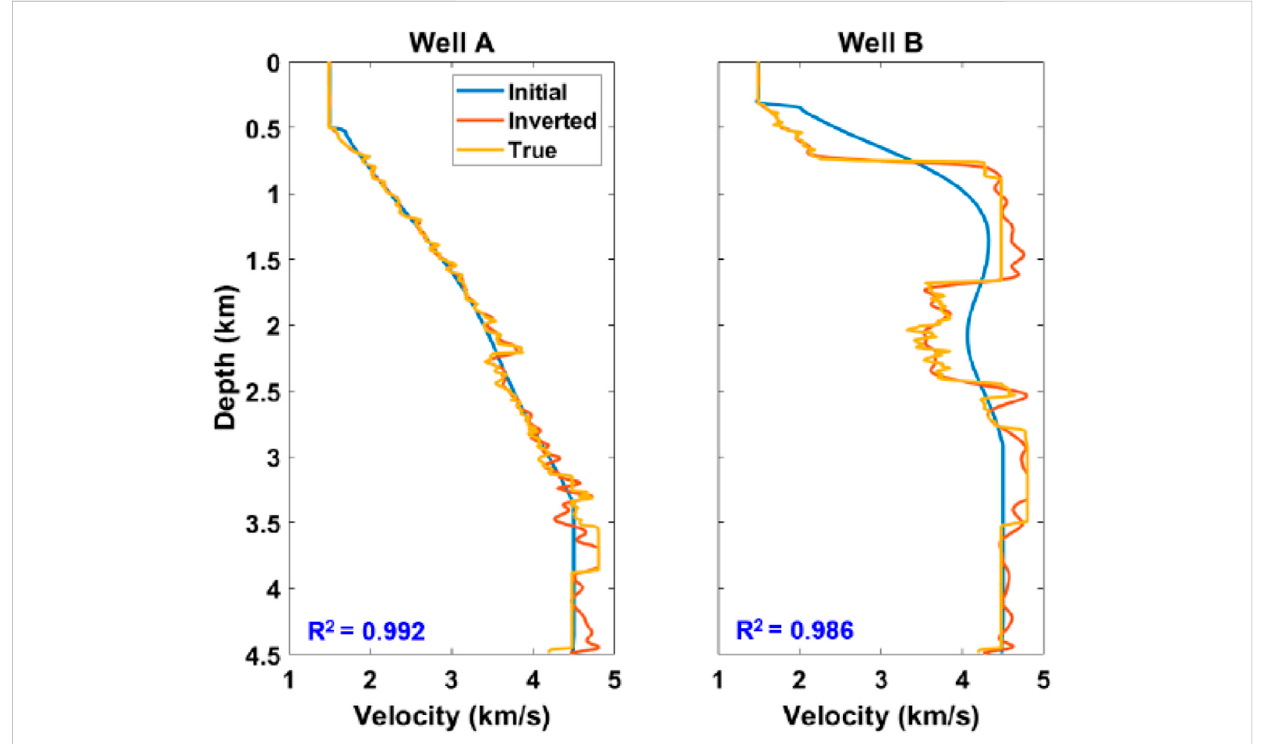
FIGURE 8 Initial and inverted velocity model comparison of two validation wells. The blue curve denotes the initial velocity, and the red curve denotes the inverted velocity. As can be seen, the inverted velocity model matches with the true velocity